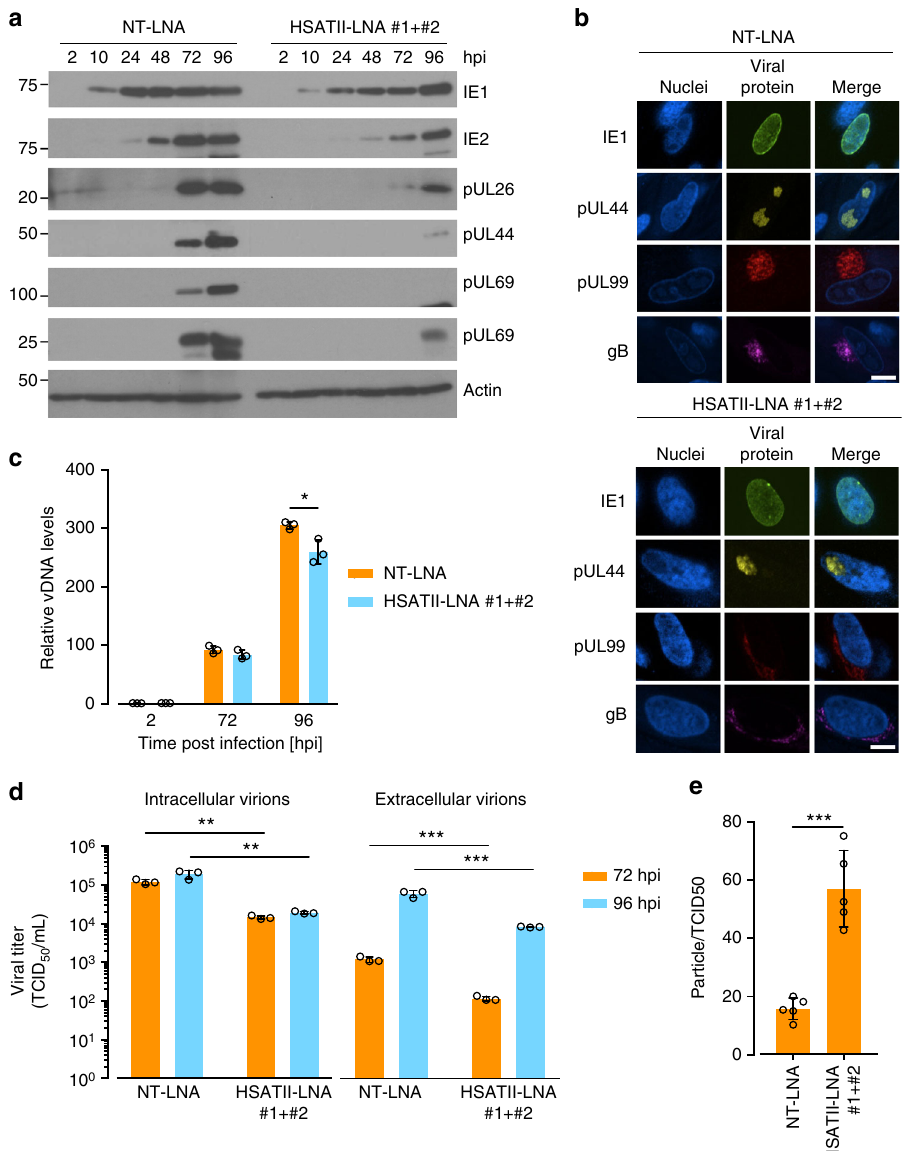
Fig. 4 HSATII RNA is important for viral protein expression and localization, viral replication and release. a Protein samples were collected at indicated times from HFFs transfected with NT-LNA or HSATII-LNAs 24 h before HCMV (TB40/E-GFP) infection at 1 TCID 50 /cell. Protein levels were analyzed by the western blot technique using antibodies speci fi c to IE1, IE2, UL26, pUL44, pUL69, and pp28. Actin was used as a loading control. b HFFs were transfected with NT-LNA or HSATII-LNAs 24 h before HCMV (TB40/E) infection at 1 TCID 50 /cell. At 72 hpi, cells were fi xed and stained for IE1, ppUL44, p28 or gB and nuclei were counterstained with the Hoechst stain. Scale bar: 15 µ m. c Total DNA was collected at indicated times from HFFs transfected with NT-LNA or HSATII-LNAs 24 h before HCMV (TB40/E-GFP) infection at 1 TCID 50 /cell. vDNA and cellular DNA copy numbers were determined. Data are presented as a fold change mean ± SD of the relative vDNA to cellular DNA ratio. n = 3. * P < 0.05 by the unpaired, two-tailed t -test. Open circles represent single data points. d Intracellular and extracellular virions were collected at indicated times from HFFs transfected with NT-LNA or HSATII-LNAs 24 h before HCMV (TB40/E-GFP) infection at 1 TCID 50 /cell. TCID50 ml − 1 values were determined. Data are presented as a mean ± SD. n = 3. ** P < 0.01, *** P < 0.001 by the unpaired, two-tailed t -test. Open circles represent single data points. e Particle-to-TCID 50 ratios were calculated based on the TCID 50 assay and vDNA copy numbers generated from media samples collected at 96 hpi from HFFs transfected with NT-LNA or HSATII-LNAs 24 h before HCMV (TB40/E-GFP) infection at 1 TCID 50 /cell. Data are presented as a particle-to-TCID 50 ratio mean ± SD. n = 5. *** P < 0.001 by the unpaired, two- tailed t -test. Open circles represent single data